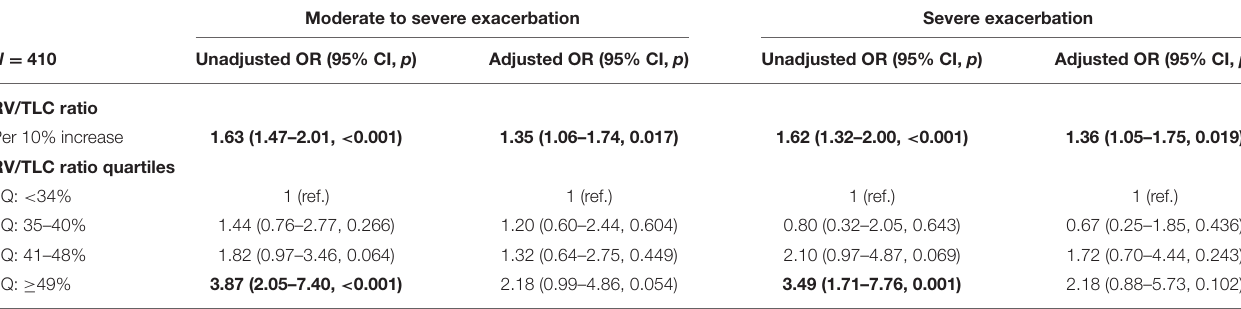
TABLE 3 | The RV/TLC ratio and the risk of COPD exacerbation. Moderate to severe exacerbation Severe exacerbation